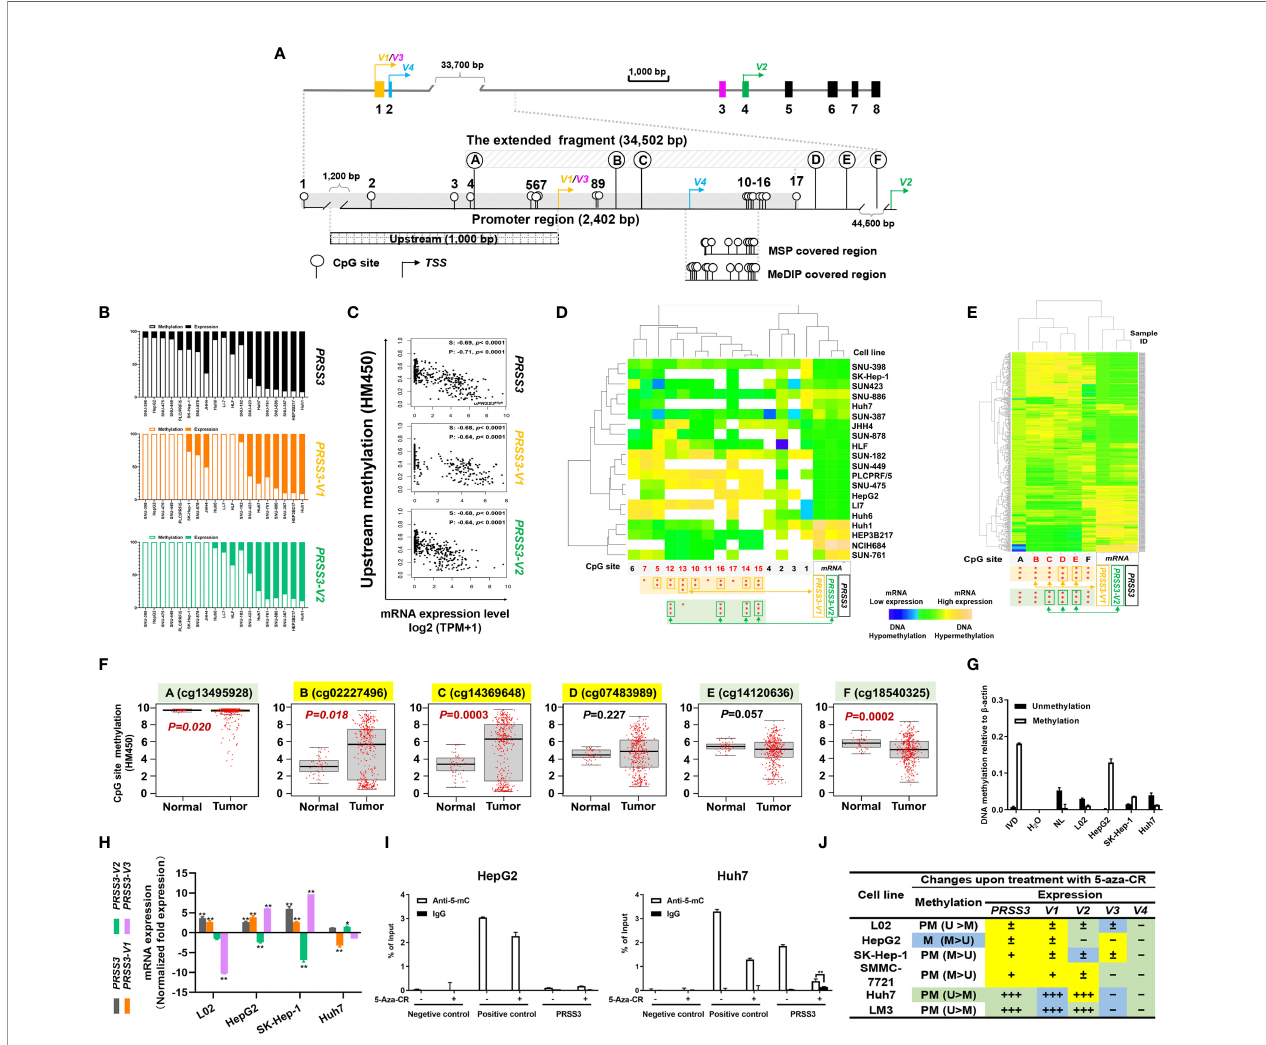
FIGURE 3 | CpG methylation in the regulation of PRSS3 transcript expression in HCC. (A) Schematic of the PRSS3 5 ’ -genomic region including the extended promoter region and upstream and extended fragments. The promoter region (-1749 to 653 bp) shared by PRSS3 - V1 / 3 contains 17 CpG sites (CpGs), including 5 CpGs (CpG sites 2-7) in the 1 kb upstream fragment (-1000 bp from the TSS of PRSS3 - V1 / 3 ). The extended fragment includes 6 CpGs (de fi ned as A – F ) scattering around a broad genomic region approximately 34.5 kb from -170 to 34,654 bp of the PRSS3 - V1 / 3 TSS but -10,643 bp from the TSS of PRSS3 - V2 . The genomic position of each CpG site is shown relative to the TSS of PRSS3 - V1 / 3 ( Table S4 ). Primer-covered regions for MSP-qPCR and MeDIP-qPCR are shown. (B) 1 kb upstream methylation normalized as a percentage relative to PRSS3 expression in HCC cell lines visualized by a 100% stacked bar graph. (C) Spearman and Pearson correlation analysis of 1 kb upstream methylation associated with PRSS3 expression in human primary liver tumor samples (n=371). (D, E) Clustered heatmap of the correlation between CpG site methylation and PRSS3 transcript expression. Data were visualized by using correlation as a distance function for heatmap cluster analysis of CpG methylation at the promoter in 20 HCC cell lines (D) and at the extended fragment in HCC tissue specimens (n=414) (E) . In the heatmap, blue indicates low, green indicates intermediate and yellow indicates high DNA methylation or mRNA values. Rows: CpG sites arranged based on the correlation between the methylation and mRNA expression levels of PRSS3 transcripts. The values of DNA methylation levels were renormalized with mean=0 and standard deviation=1. Columns: HCC cell lines or tissue specimens. The statistical signi fi cance of correlation coef fi cients between CpG sites (red) and mRNA expression of PRSS3 transcripts are shown at the bottom. * P < 0.05, ** P < 0.01, *** P < 0.001 ( Figures S3, S4 and Table S5 ). (F) Association analysis of CpG site methylation with PRSS3-SV expression in 414 HCC tissue specimens compared with 41 normal controls (Wilcoxon rank sum test). (G) MS-qPCR of PRSS3 methylation in HCC cell lines and L02 cells. In vitro methylated DNA (IVD) and normal human peripheral lymphocyte DNA (NL) served as positive and negative methylation controls, respectively. (H) RT – qPCR of the expression of PRSS3 transcripts in HCC cell lines and L02 cells upon treatment with the epigenetic reagent 5-aza-CR (5 m M, 96 h). * P < 0.05, ** P < 0.01 by Student ’ s t test. (I) MeDIP-qPCR to analyze 5-mC-enriched genomic DNA associated with the extended promoter region in HCC cell lines and L02 cells after 5-aza- CR treatment. ** P < 0.01 by Student ’ s t test. (J) In the summary table, the differential expression changes of PRSS3 transcripts responding to treatment with 5-aza-CR are visualized with symbols and colors. Methylation was de fi ned as partial methylation (PM) or methylation (M) based on the MSP results. PRSS3 expression: “–” , < 0.001%; “ ± ” , 0.001-0.05%; “ + ” , > 0.05%; “ +++ ” , > 1%. The fold changes upon 5-aza-CR treatment are shown in color: yellow, upregulation; green, downregulation; blue, no